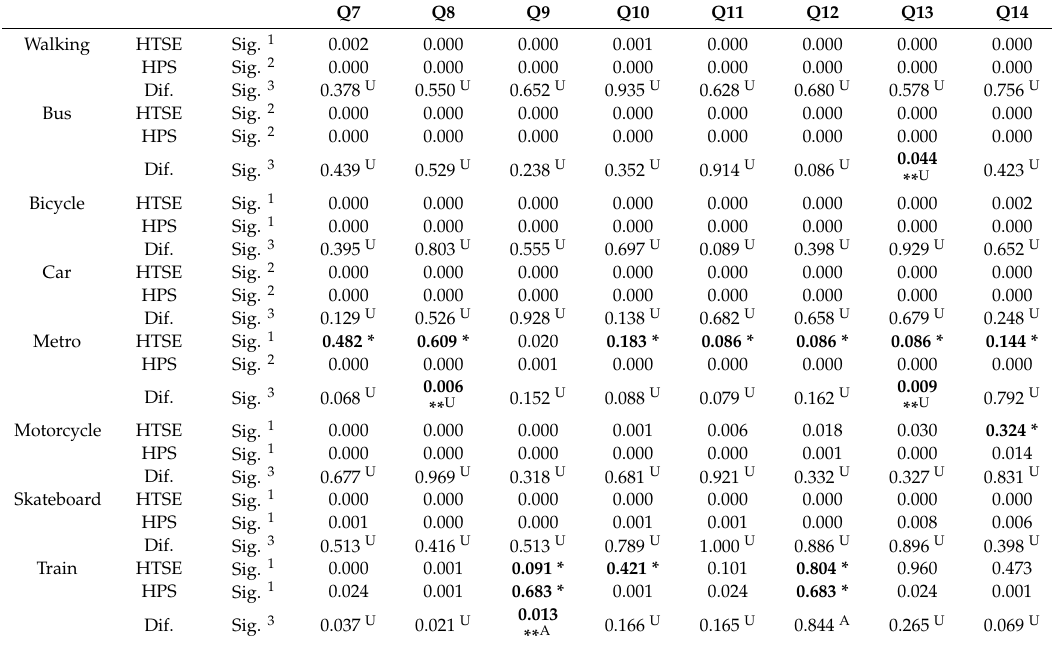
Table 3. Results of normality tests and di ff erences between simples (ANOVA and non-parametric test).